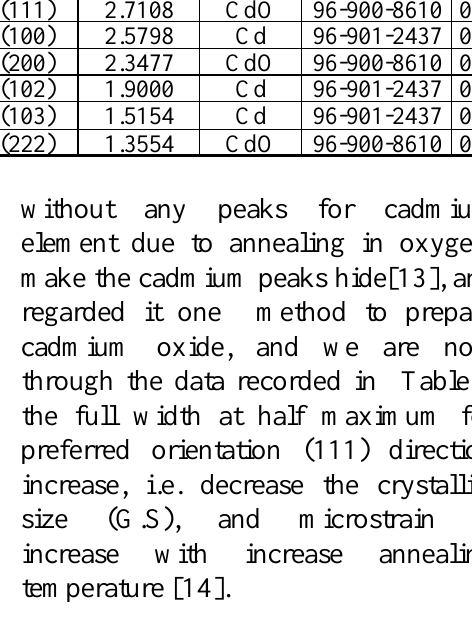
Table 1: XRD peaks, standard and experimental d deposited by voltage (1200) Volt at room temperature. 2θ